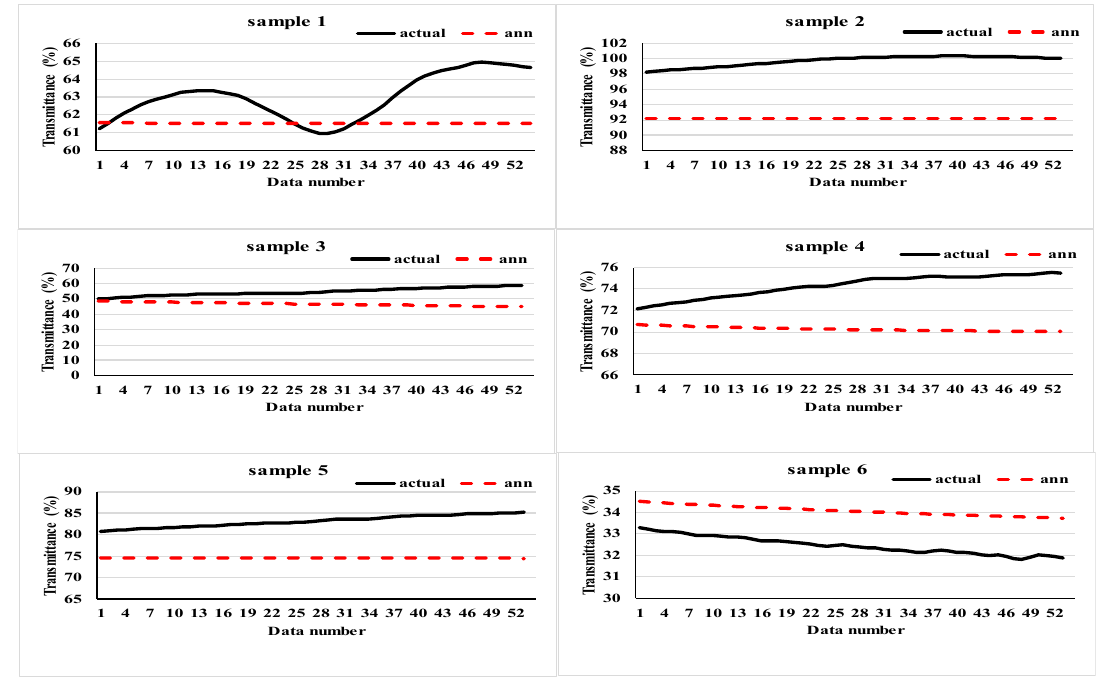
Figure 10. FTIR spectra experimental results compared with ANN result.